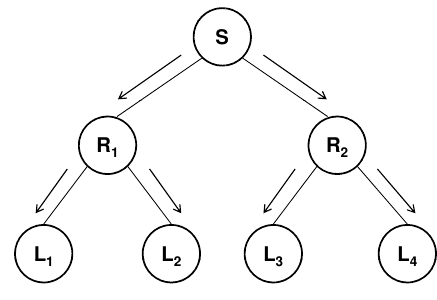
Figure 1. One-to-many communication using a tree